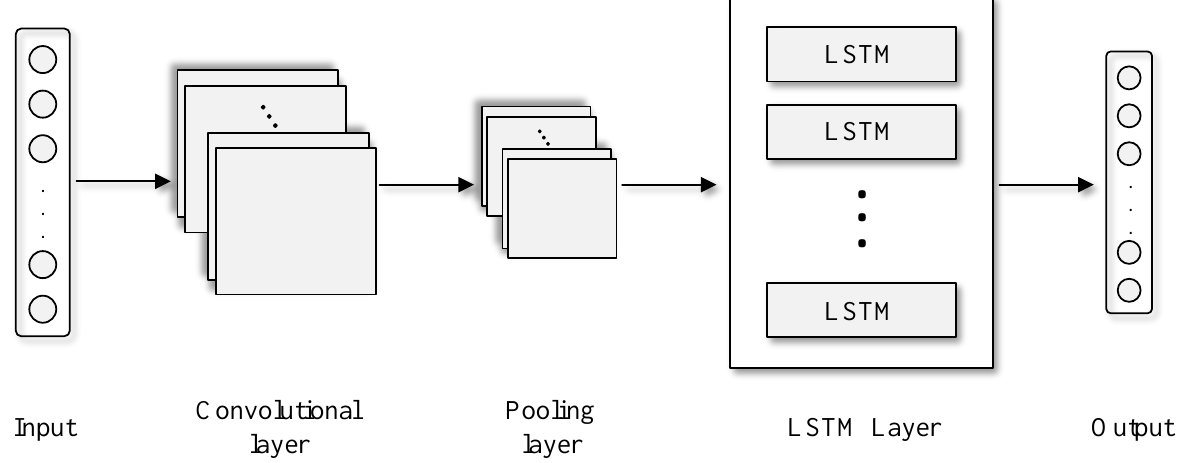
Figure 8. CNN-LSTM NN architecture.